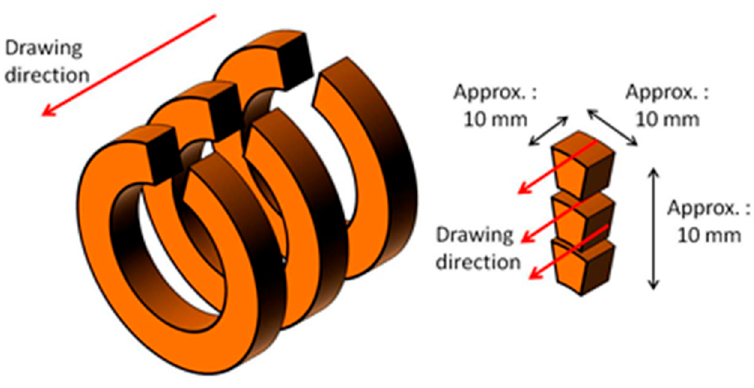
Figure 3. Schematic representation for preparation of the samples for the global texture measure- ments.